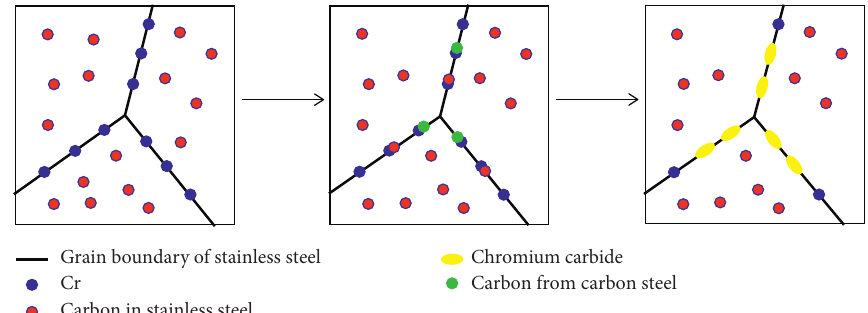
Figure 13: Schematic illustration of the formation of chromium-depleted region in the stainless steel/carbon steel bimetal